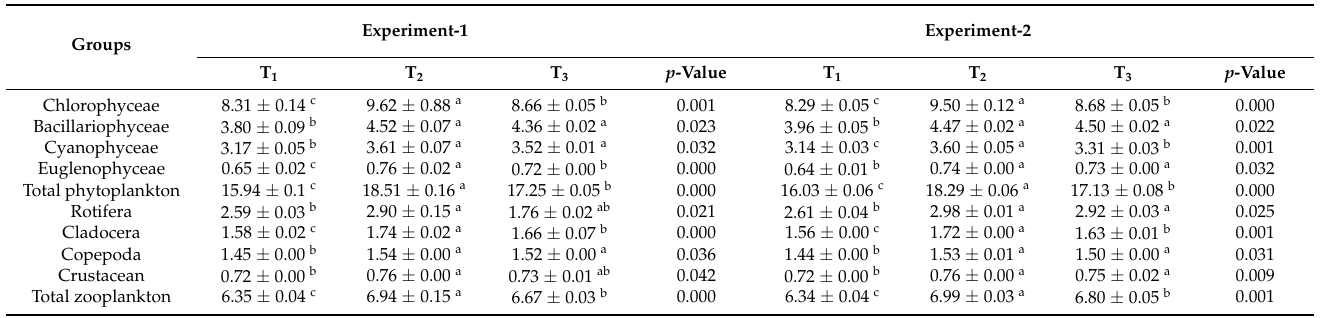
Table 2. Variation in the cell density ( × 10 3 cells/L) of major groups of phytoplankton and zooplankton.